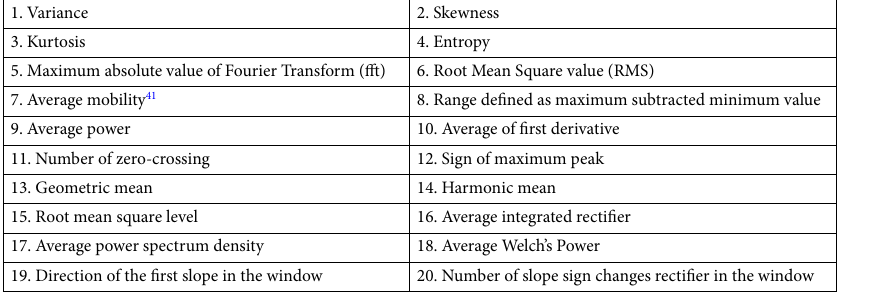
Table 3. List of features that used in training